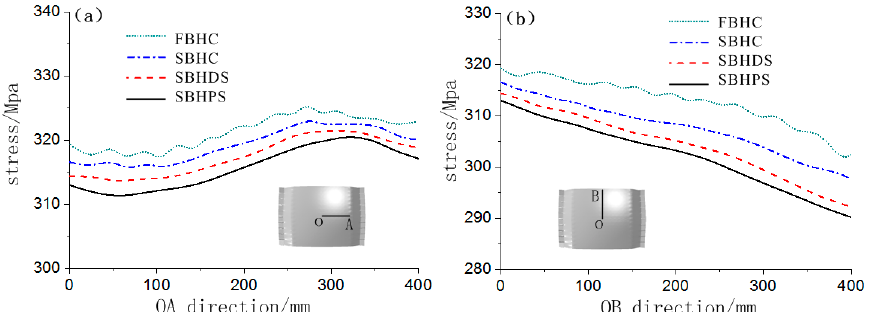
Figure 8. Stress distribution curves of the formed parts: ( a ) along the OA direction; ( b ) along the OB direction.